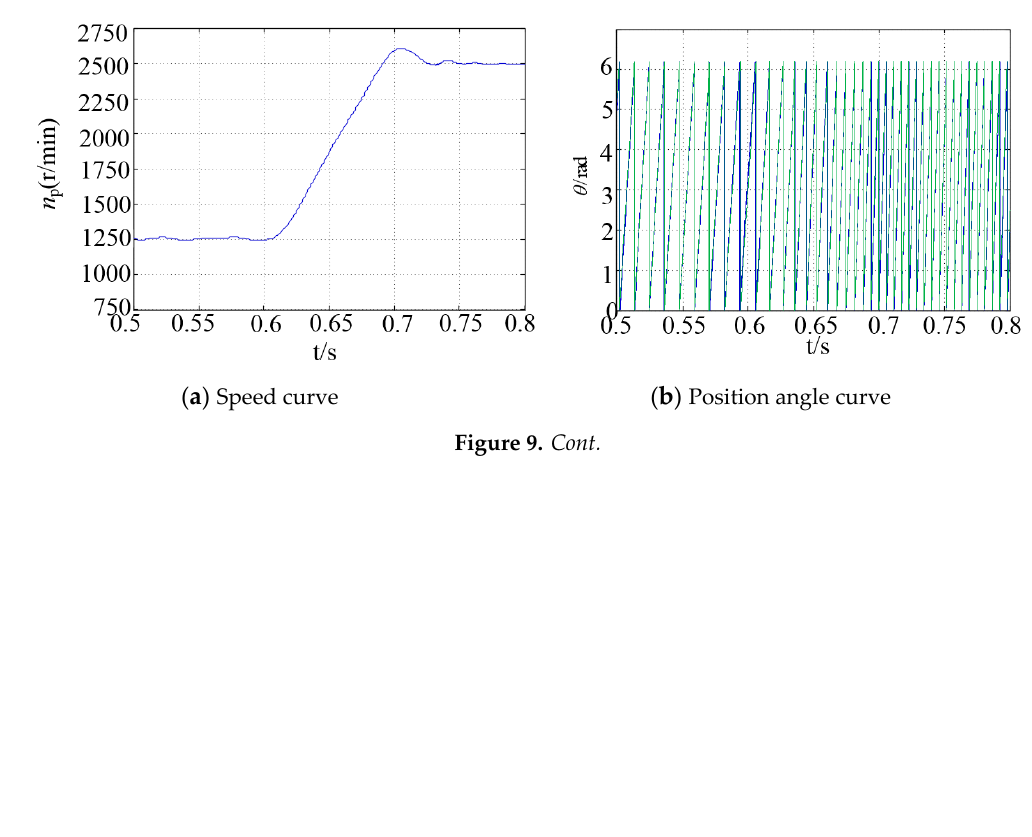
Figure 8. Simulation response curves of the STA-SMO.